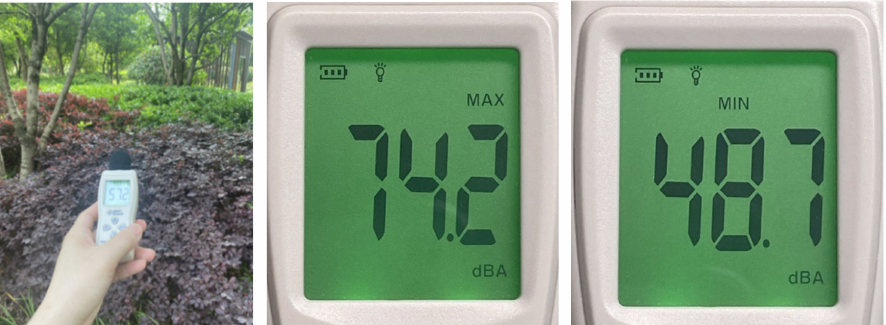
Figure 4. The Smart Sensor Digital Sound Level Meter AS804 used in the soundscape experiment. The figure and image was produced by the